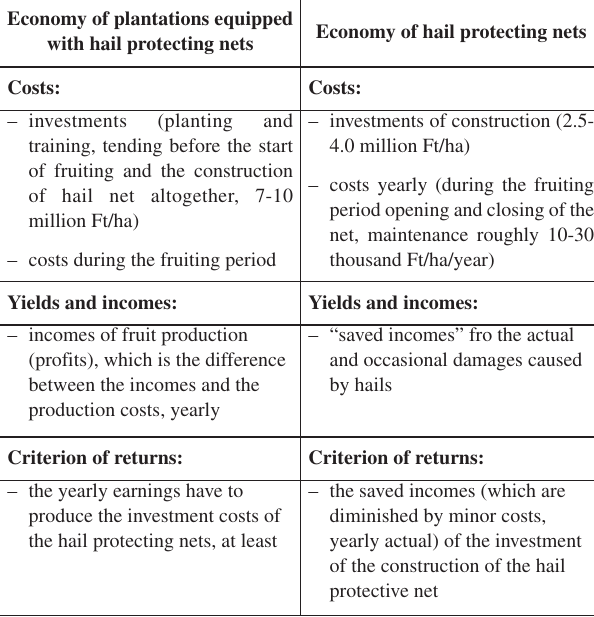
Table 1. Economic judgment of hail protecting nets and that of plantations equipped with hail nets Economy of plantations equipped Economy of hail protecting with hail protecting nets